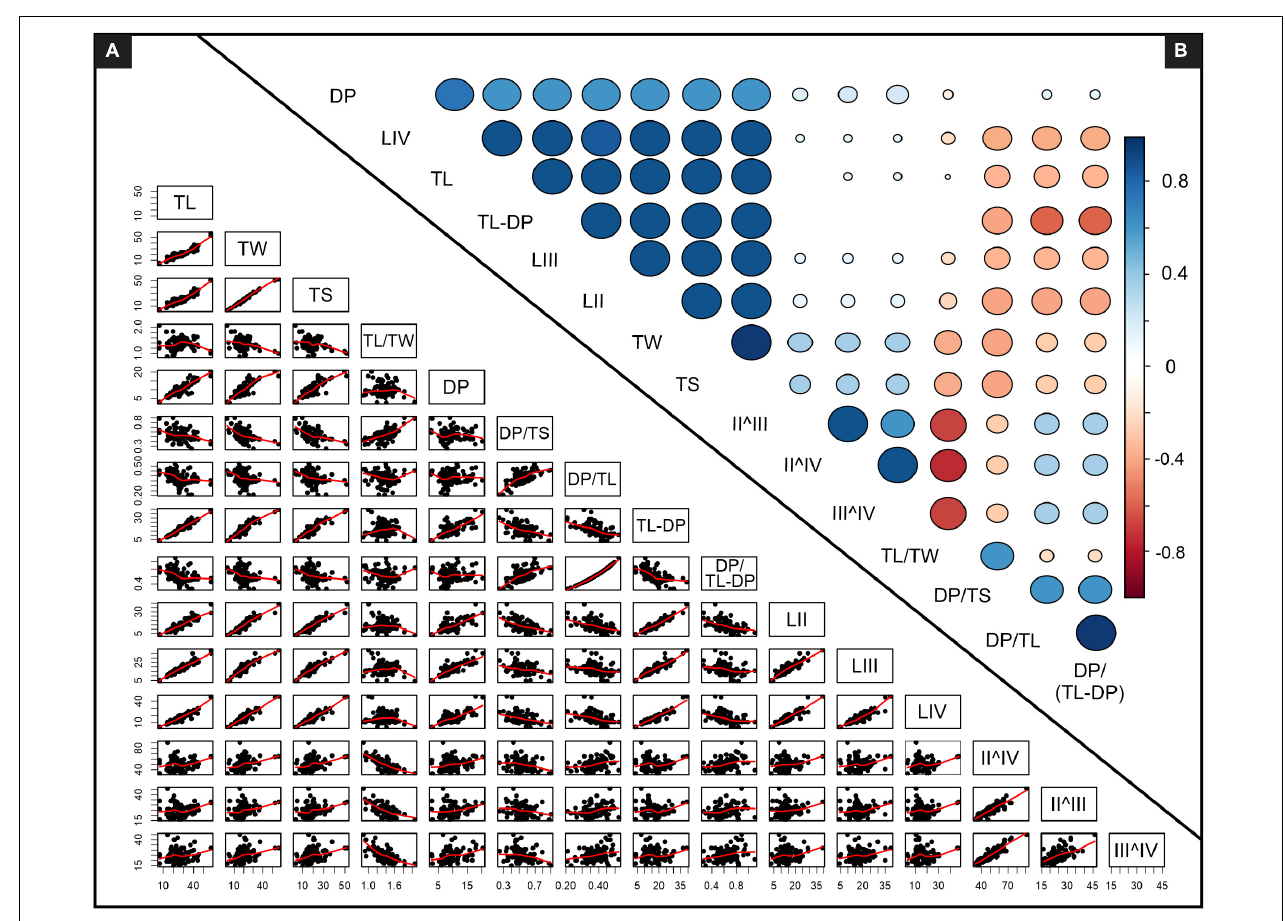
FIGURE 3 | Relationships between bivariate analyses (STA-CON). (A) Pairwise scatter plots with locally weighted scatterplot smoothing (LOWESS) fit lines, (B) Correlation matrices between measured parameters where larger circle diameters correspond to stronger correlations and blank spaces indicate negligible correlations. See Supplementary Figure 2 for enlarged TL versus DP and TL versus bivariate ratio scatterplots and Supplementary Table 2 for detailed matrices data. TL – track length, TW – track width, TS – track span, DP – digit III projection, LII, LIII, LIV – respective digit II, III and IV lengths, IIˆIV, IIˆIII, IIIˆIV – respective interdigital